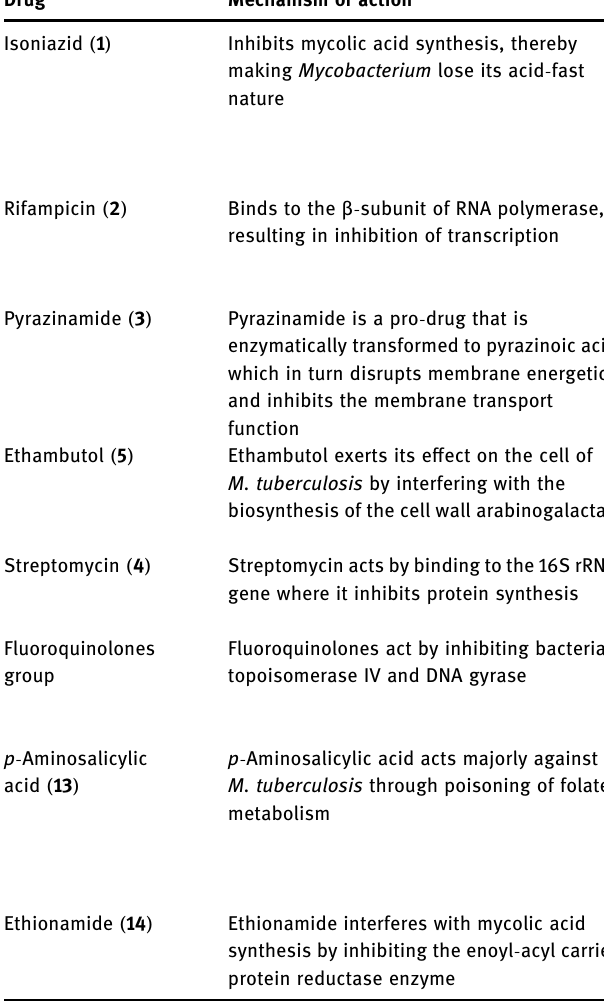
Table 2: Mechanism of antimicrobial resistance and antituberculosis drugs